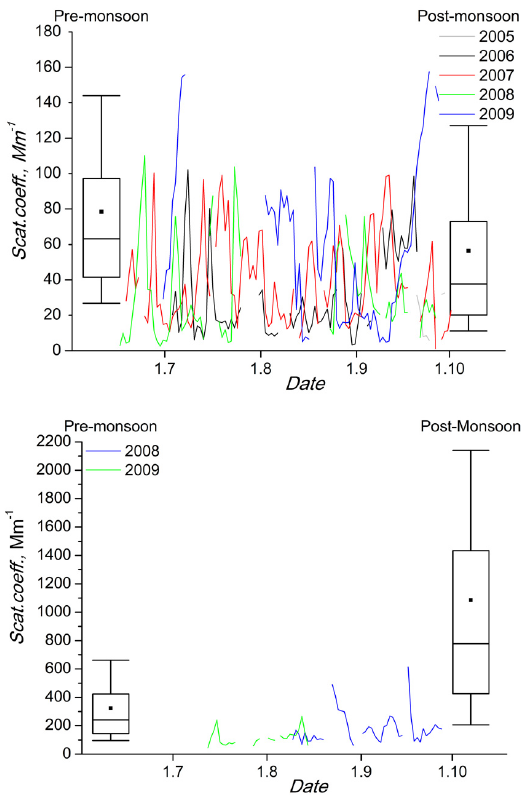
Fig. 7. Absorption coefficient (a) at 520nm in Mukteshwar (b) at 637nm in Gual Pahari. Lines are 24h running averages from the monsoon season, box plots denote to pre- and post-monsoon seasonal values of 10%-ile, 25%-ile, median (line), average (dot), 75%-ile and